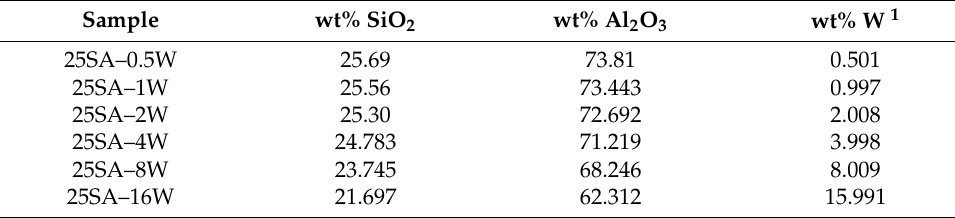
Table 8. Composition of the 25SA–WO x microspheres calcined at 550 ◦ C.